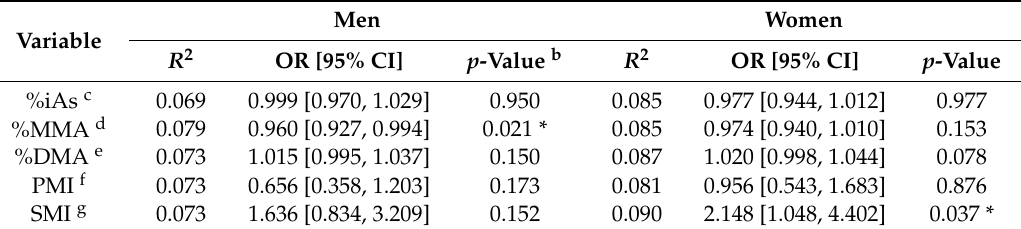
Table 4. Binary logistic regression, fully adjusted a .